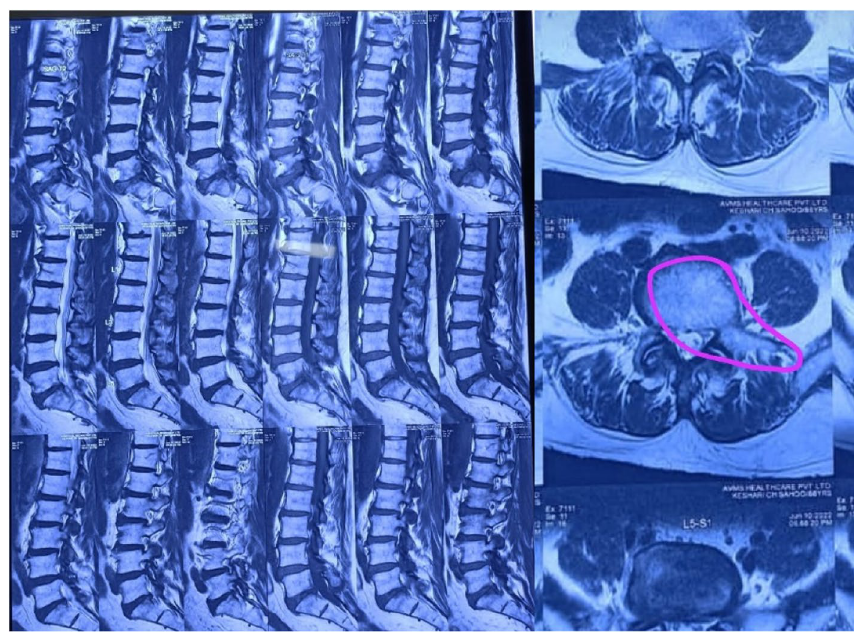
Fig. 1 MRI of the lumbar spine showing